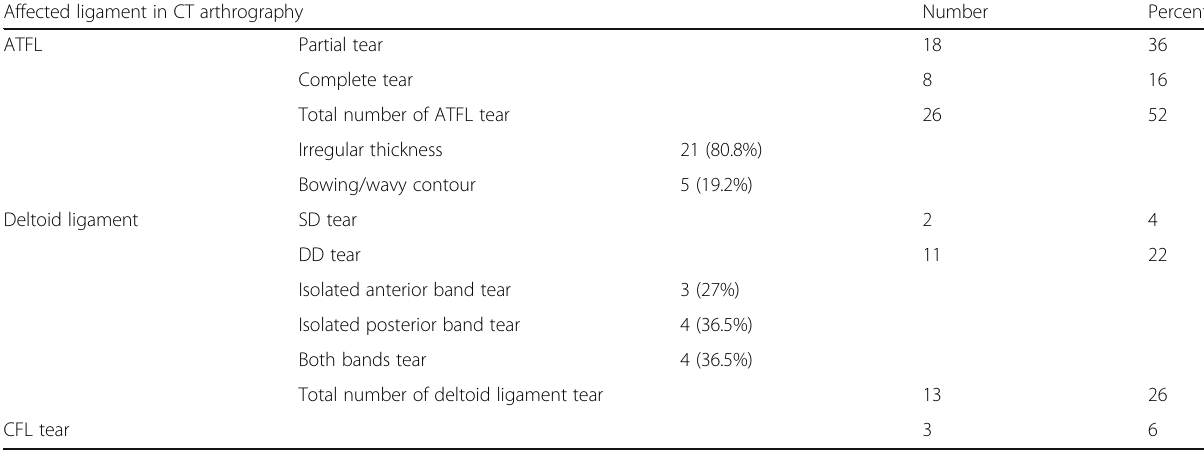
CFL tear ATFL anterior talo-fibular ligament, SD superficial deltoid ligament, DD deep deltoid ligament, CFL calcaneo-fibular